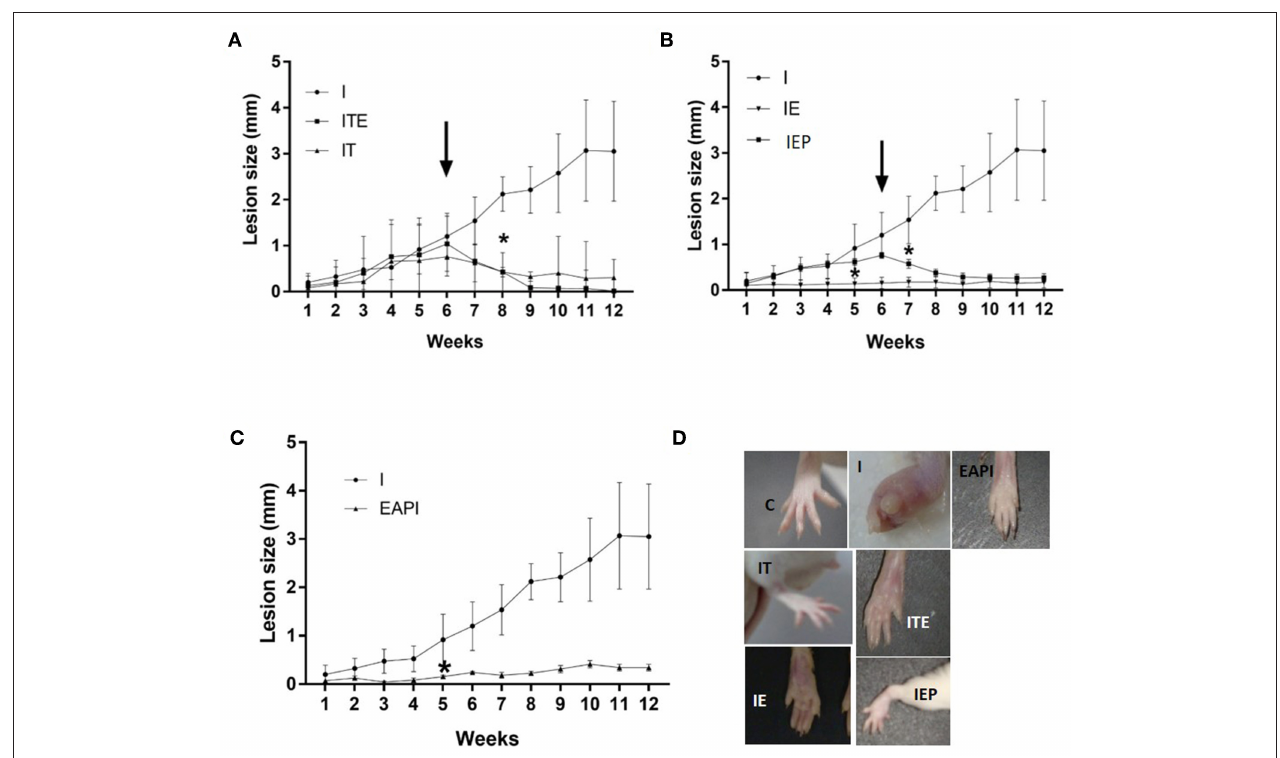
FIGURE 2 | Effect of exercise on the development of lesions on the paws of BALB/c mice that were infected with L. major (2 x 106 promastigotes): (A–C) The size of paws was measured weekly for 12 weeks with a pachymeter (Mitutoyo). Results are expressed as the difference between the contralateral paw and infected paw (mm). The arrow indicates the start of training and/or treatment. Values represent the average of two experiments with 8 animals per group in each experiment. (D) A representative image of the infected footpad from 1 animal of each different group at the end of the assay (13th week). Values were expressed as mean ± SD. I—Infected. IT—Animals infected and treated with therapeutic dose (8mg) of Glucantime ® after the onset of injury. ITE - Animals infected, trained and treated with therapeutic dose (8mg) of Glucantime ® after the onset of injury. IE—infected animals trained from the first week of infection. IEP—infected animals trained after the onset of injury (6th week). EAPI—Animals trained for 6 weeks, infected and trained for 12 weeks. * The week displaying significant difference ( P < 0.001) from the control group